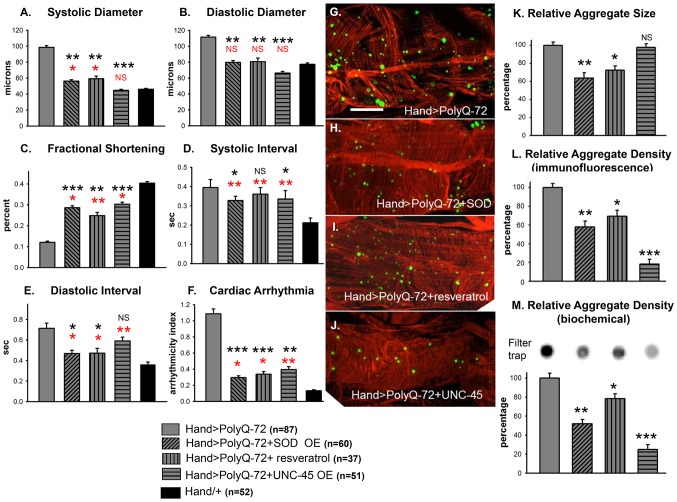
Over-expression of SOD or treatment with resveratrol or over-expression of UNC-45 all rescue PolyQ-72 induced cardiac dysfunction to some extent.(A) PolyQ-72 induced cardiac systolic and (B) diastolic diameters are reduced nearly to wild-type (Hand/+) levels. (C) Cardiac contractility (% FS) is improved upon over-expression of SOD, treatments with resveratrol or over-expression of UNC-45. (D) Systolic and (E) diastolic intervals and (F) cardiac arrhythmias from hearts expressing PolyQ-72 and expressing SOD-1 or fed resveratrol or expressing UNC-45 were reduced approaching towards wild-type values compared to hearts expressing PolyQ-72 alone. Hearts were from 3-week old flies. (A–F) Data shown as mean ± SE. (G) Myofibrillar organization and GFP-positive aggregates in PolyQ-72 expressing hearts and (H) in PolyQ-72 hearts over-expressing SOD or (I) flies fed resveratrol or (J) hearts over-expressing UNC-45. (K) Relative GFP-aggregate size was reduced in response to SOD over-expression or feeding resveratrol, however, over-expression of UNC-45 did not affect the average aggregate size. (L) Quantification of the number of aggregates per unit area shows that all treatments significantly reduced the density of aggregates formed in response to PolyQ-72 expression. K and L shows averaged data from 4 to 6 hearts, expressed as a percent relative to the mutant PolyQ. (M) Quantification of relative GFP-aggregate density with the filter trap assay. An example of one filter trap blot is shown (top), and the averaged densitometric scan results expressed as a percent relative to the mutant PolyQ (bottom). Compared to Htt-PolyQ-72, treatments with resveratrol or over-expression of SOD or UNC-45 reduced PolyQ-induced aggregation to different extents. For all panels significance was determined using a one-way ANOVA and Dunnett's post hoc test. Significant differences were assumed for p<0.05. (*** = p<0.001, ** = p<0.01, * = p<0.05, NS = no statistical difference, p>0.05). Red * and NS indicate differences relative to the Hand/+ control; black text indicates differences relative to mutant PolyQ-72. Scale bar in G is 20 µm.